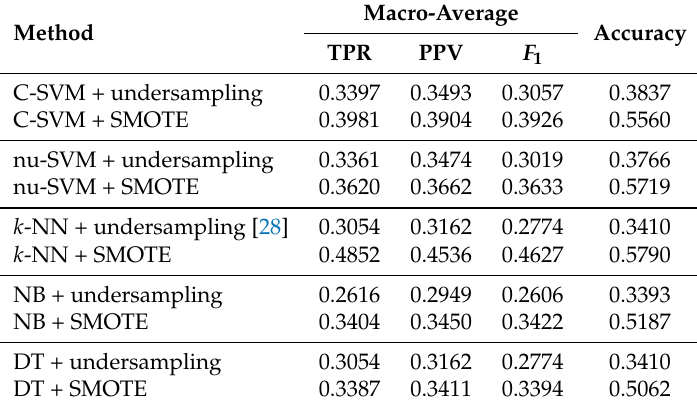
Table 12. Performance comparisons of the five benchmark methods over leave-one-person-out cross validation.